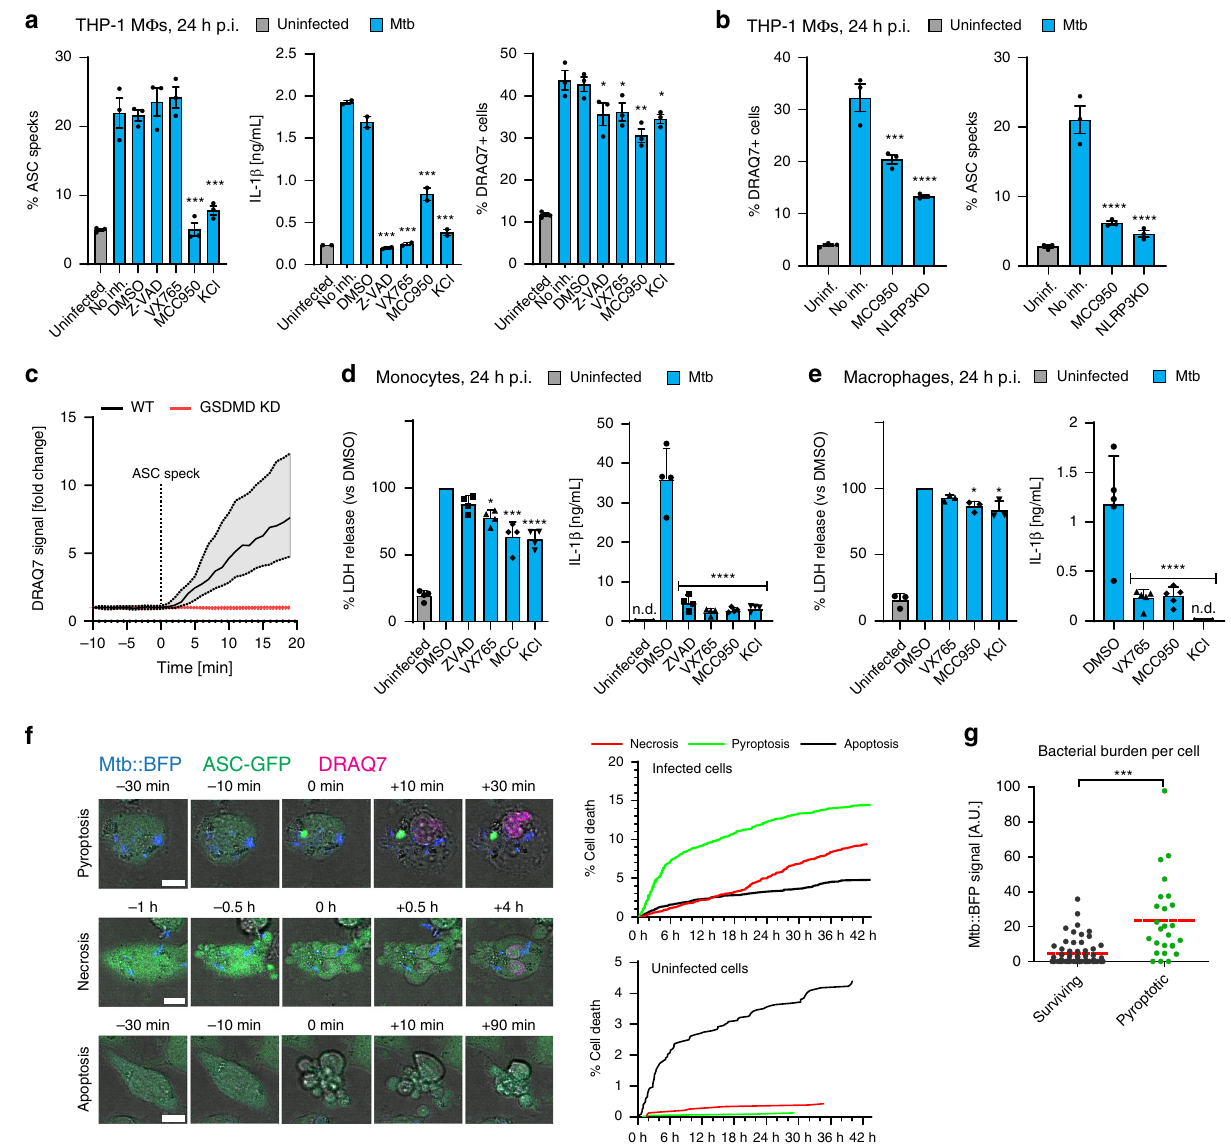
Fig. 1 Mtb H37Rv infection induces canonical NLRP3 activation. THP-1 ASC-GFP macrophages were infected by Mtb-BFP and imaged by time-lapse microscopy or at 24 h post infection (p.i.). a Cells were treated with DMSO control, caspase inhibitors (Z-VAD-FMK (pan-caspase) or VX765 (caspase-1)) or NLRP3 inhibitors (MCC950, KCl). DRAQ7 + cells and ASC specks were quanti fi ed at 24 h p.i. IL-1 β release was determined by ELISA. b THP-1 ASC- mNeonGreen (WT) or NLRP3 KD cells were infected by Mtb and imaged 24 h p.i. c To assess the role of GSDMD in cell death in cells with ASC speck formation, THP-1 ASC-mNeonGreen (WT) or GSDMD KD cells were infected with Mtb and imaged live. DRAQ7 intensity during ASC-speck formation was measured in single cells in WT ( n = 57) and GSDMD KD ( n = 81) cells. Median ± IQR are shown. d Primary human monocytes were treated with inhibitors and infected with Mtb, and LDH and IL-1 β release were determined 24 h p.i. n.d. — below detection limit. n = 4 biologically independent samples examined over two independent experiments. e Primary human macrophages were treated with inhibitors and infected with Mtb. LDH and IL-1 β release were determined 24 h p.i. n = 3 and n = 5 biologically independent samples for LDH and IL-1 β data, respectively. f The prevalence of pyroptosis was assessed by quantifying the cumulative number of pyroptotic, necrotic and apoptotic cell death events in THP-1 ASC-GFP cells from a 45-h time-lapse experiment during infection with Mtb. Representative cell death events are shown. Scale bars 10 µ m. Data representative of two independent experiments. g The bacterial burden (intracellular Mtb-BFP fl uorescence) was determined immediately before ASC-speck formation in pyroptotic cells ( n = 26), and at the average time of ASC-speck formation in cells surviving the 24-h experiment ( n = 61). Lines indicate median values. Bars show mean ± s.e.m. in ( a , b ) and mean ± s.d. in ( d , e ). * p < 0.05, ** p < 0.01, *** p < 0.001, **** p < 0.0001, by one-way ANOVA with two-sided Dunnett ’ s test in ( a , b ), repeated measures ANOVA with two-sided Dunnett ’ s test in ( d , e ) and two-sided Mann – Whitney test in ( g ). Data in ( a – c ) representative of three independent experiments with n > 2000 cells in technical triplicates per condition. Source data are provided as a Source Data fi